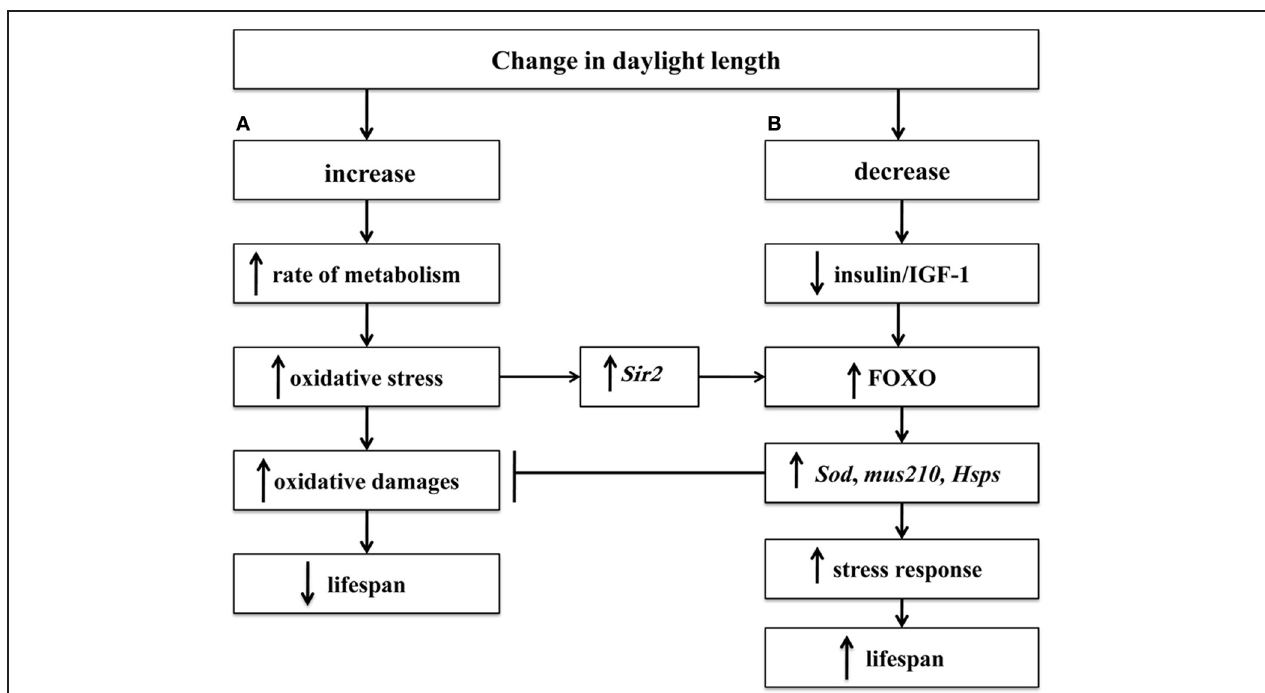
FIGURE 1 | The mechanism of the influence of the light regime on lifespan: metabolism intensification in light conditions (A) and FOXO-dependent increase of lifespan in dark conditions (B). Symbol: → , induction; (cid:3) , inhibition; ↑ , increase; ↓ , decrease.